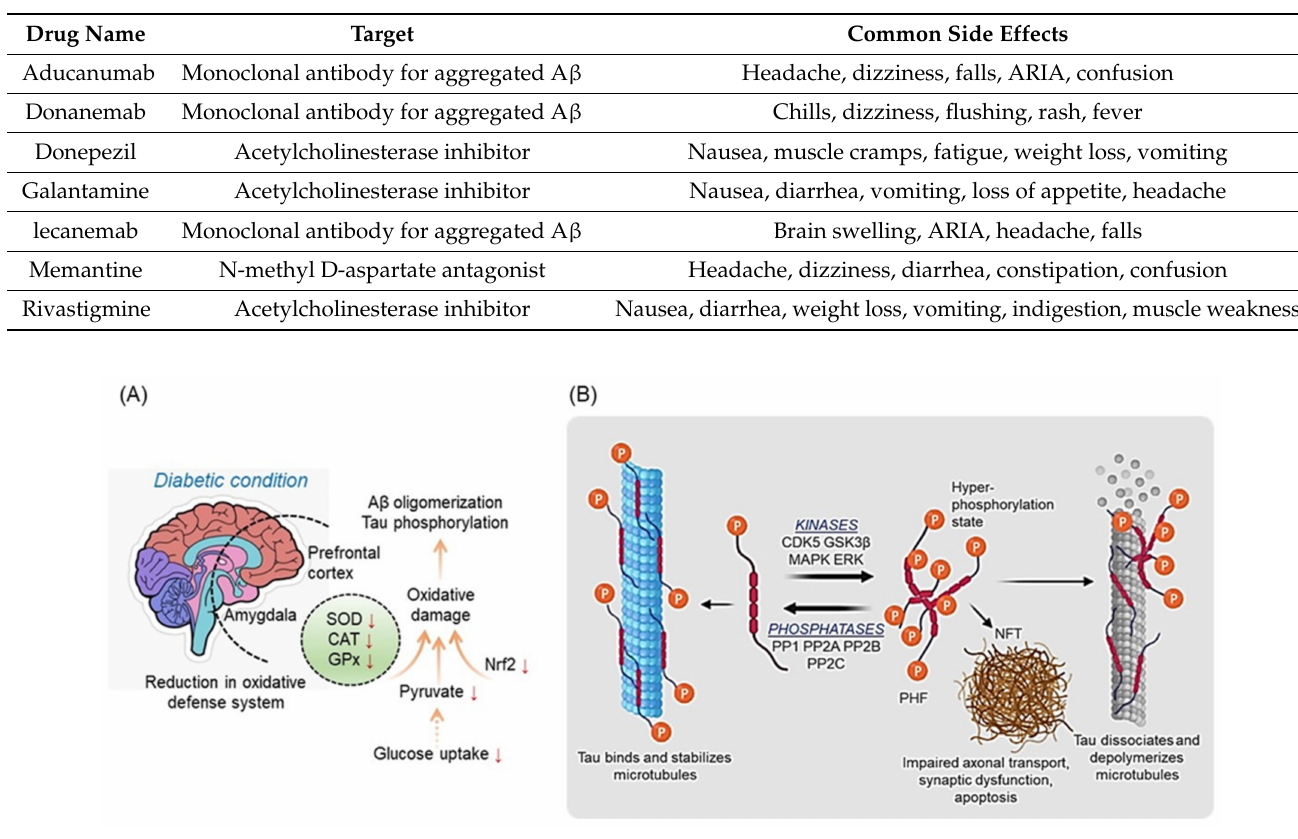
Figure 6. ( A ) The inhibition in the oxidative defense system potentiates A β oligomerization and Tau phosphorylation in the diabetic brain. ↓ arrows indicate downregulation. ( B ) Tau phosphorylation and NFT formation. In a healthy cell, phosphorylated tau protein binds with microtubules (MT) and maintains stability. However, hyperphosphorylation tau aggregates into the NFTs which leads to MT instability. This figure was drawn using BioRender application (https://biorender.com (accessed on 21 June